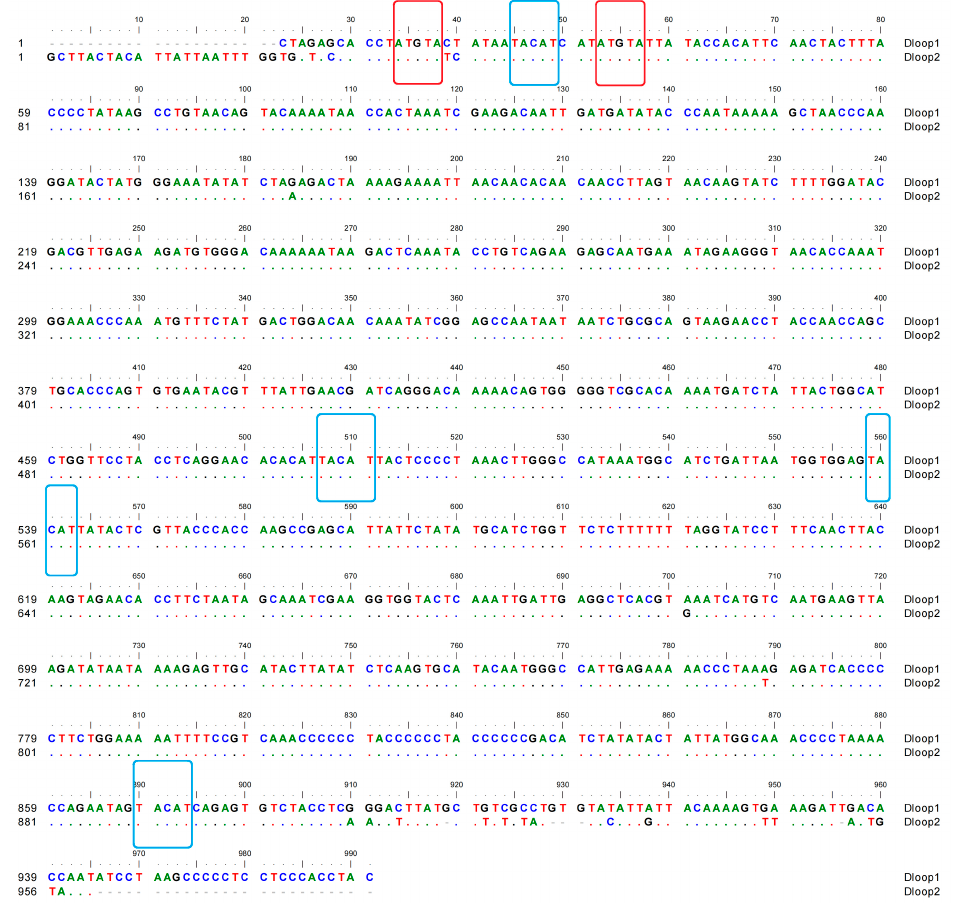
Figure 5. Compositional features of the control region of the A. meeki mitochondrial genome. The palindromic motif sequences “TACAT” and “ATGTA” are marked in blue and red, respectively.